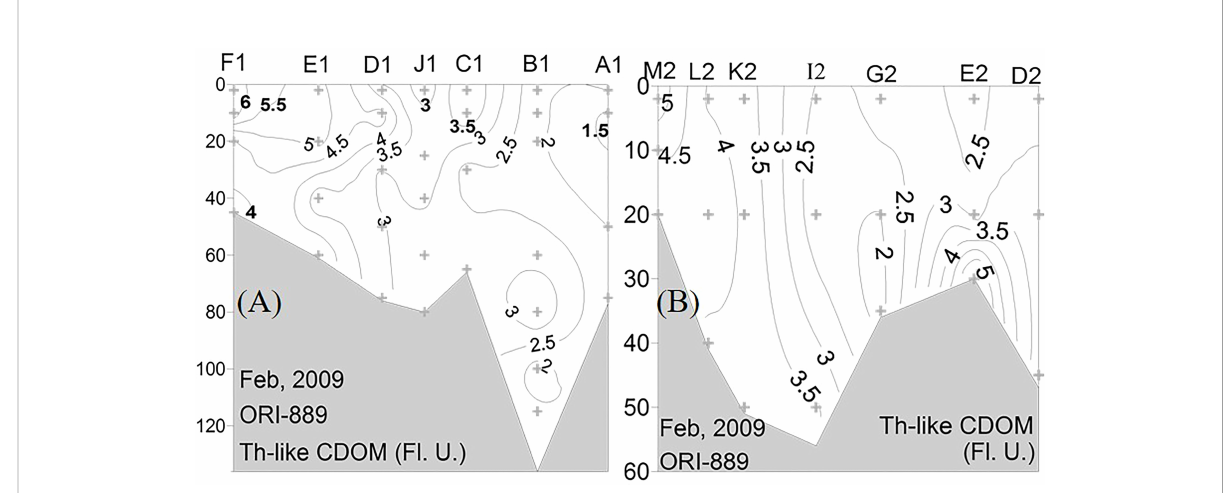
FIGURE 13 Distributions of Th-like CDOM along the northern (A) and southern (B) TS-crossin transects in